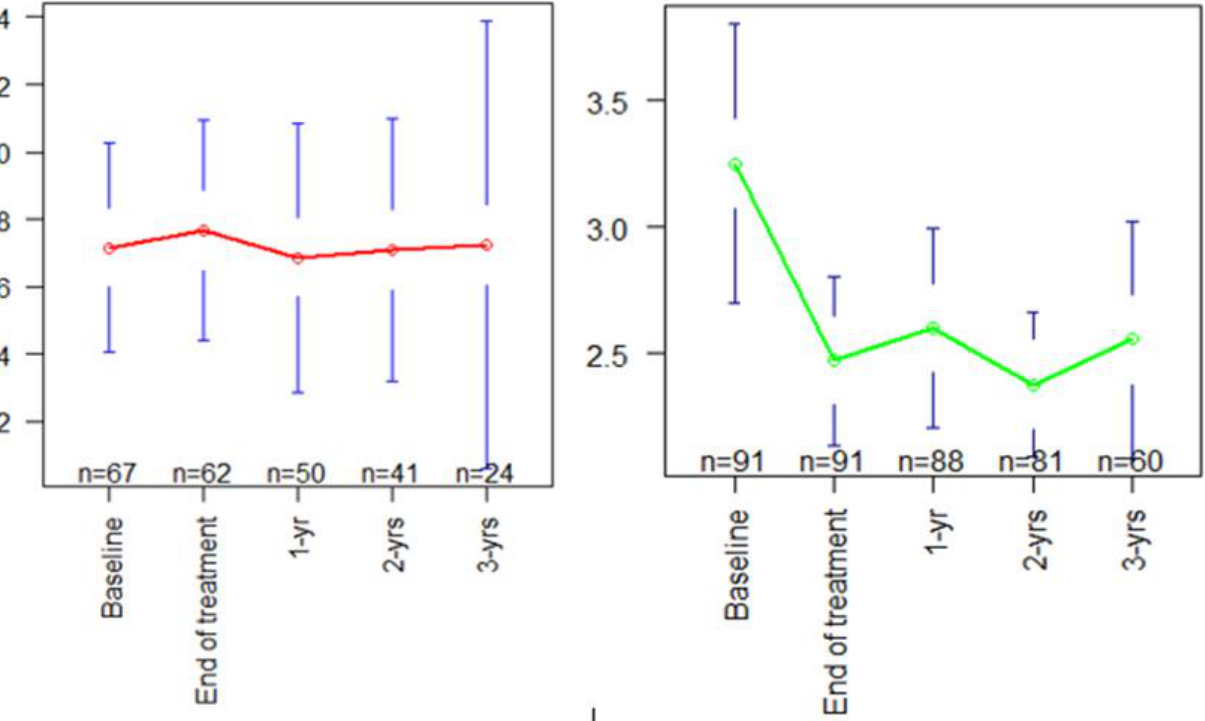
Figure 2. Dynamics of ASCVD and FIB-4 scores with time at baseline and follow-up (mean [95%CI]). After DAA treatment, mean ASCVD scores (in red) did not show significant change from baseline, whereas mean FIB-4 scores (in green) abruptly decreased starting at the end of treatment. ASCVD, Atherosclerotic Cardiovascular Disease 2013; FIB-4, fibrosis-4 index.